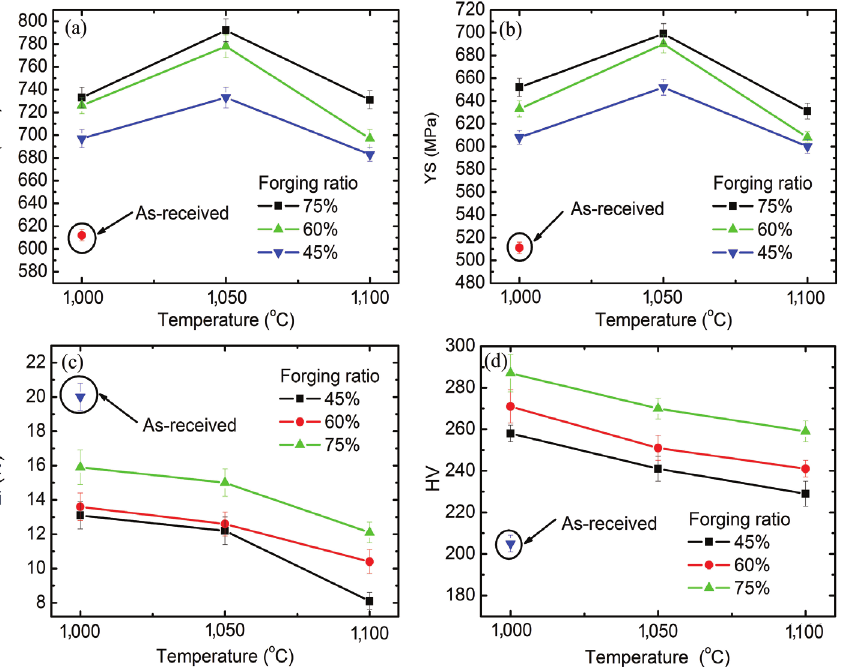
Figure 9: The tensile properties and hardness of forged Ti-7Cu alloy (Remark: UTS, tensile strength; YS, yield strength; El, elongation) (a) UTS, (b) YS, (c) El, (d)